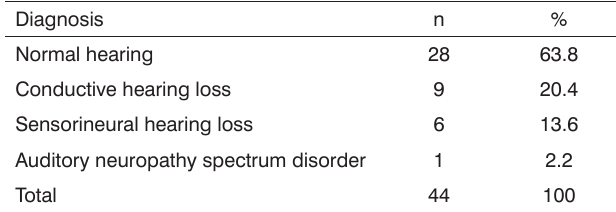
Table 3. Audiological and otorhinolaryngological diagnosis of the children who failed the auditory screening tests.